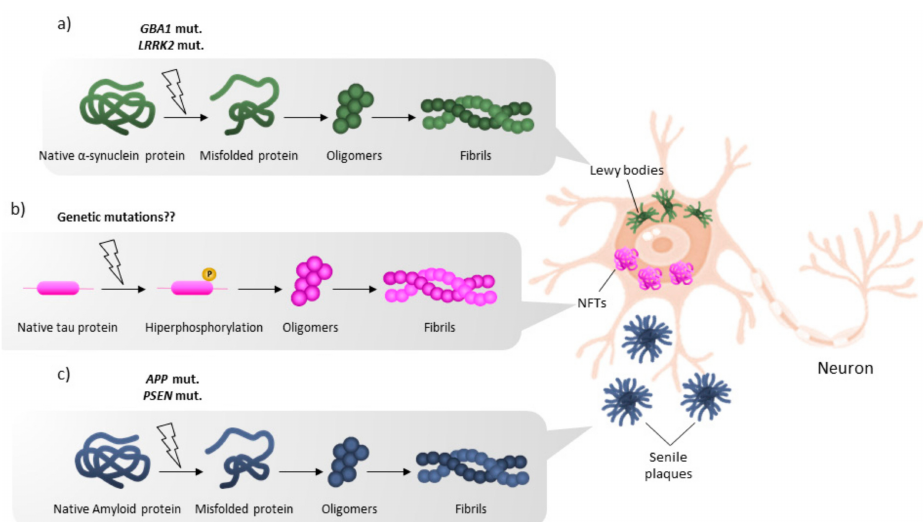
Figure 1. Scheme of pathways involved in the formation of the abnormal protein aggregates that characterize neurodegenerative diseases. ( a ) Misfolded alpha-synuclein proteins form oligomers and fibrils that aggregate into Lewy bodies in Parkinson’s disease (PD) brains and other synucleinopathies. ( b ) Aberrant hyperphosphorylation of tau leads to the formation of oligomers and fibrils that aggregate as pathological intracellular neurofibrillary tangles in Alzheimer’s disease (AD) brains. ( c ) Misfolded amyloid proteins form oligomers and fibrils that aggregate as pathological extracellular senile plaques in AD brains. NFTs: neurofibrillary